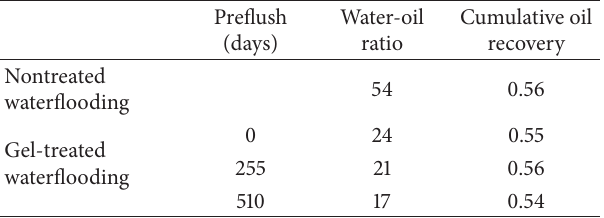
Table 8: Effects of gel treatment and preflush on water-oil ratio and cumulative